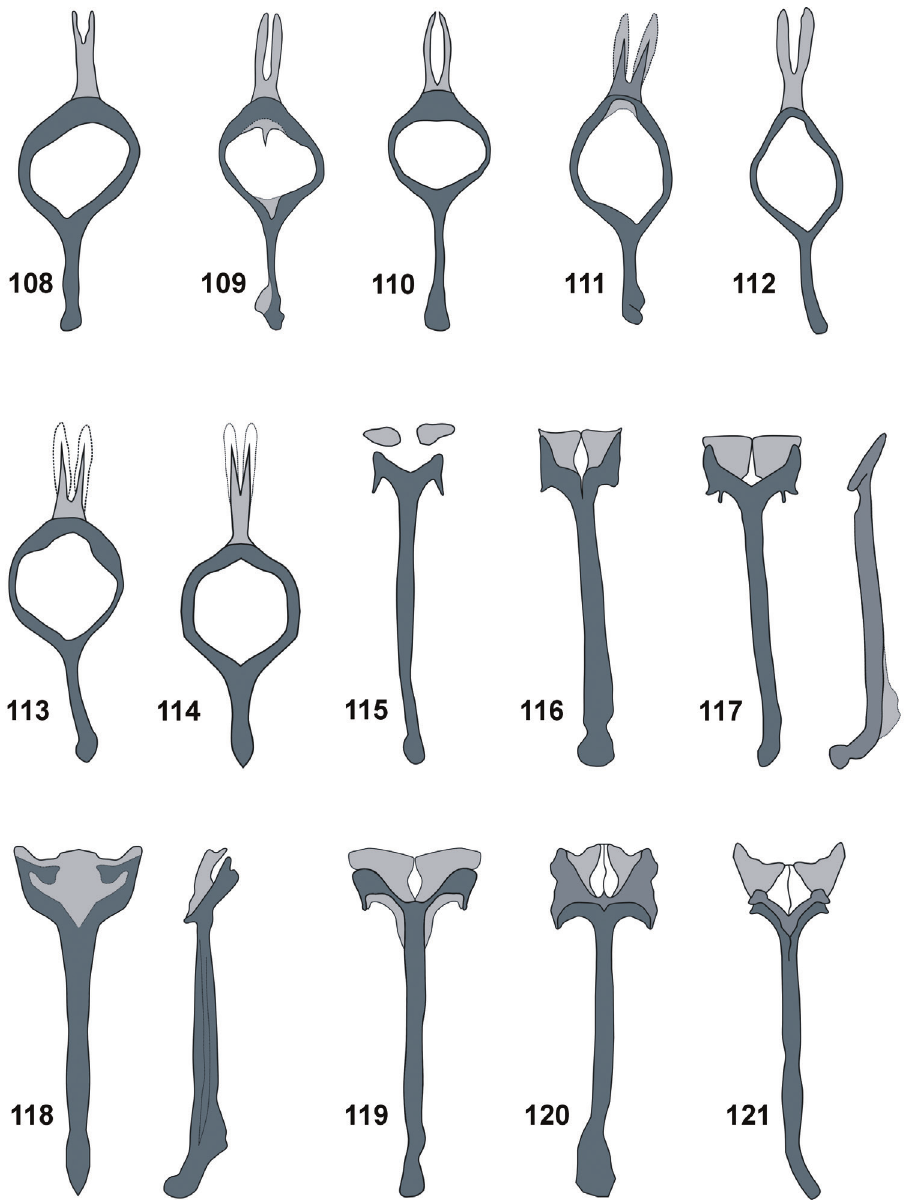
Figures 108–121. Male. Tegmen: 108 C. farinosus Perr. 109 C. fundatus sp. n. 110 C. gibbus sp. n. 111 C. malleus sp. n. 112 C. rutai sp. n. 113 C. torosus sp. n. 114 C. turbidus sp. n. Spiculum gastrale: 115 C. farinosus Perr. 116 C. fundatus sp. n. 117 C. gibbus sp. n. 118 C. malleus sp. n. 119 C. rutai sp. n. 120 C. torosus sp. n. 121 C. turbidus sp.